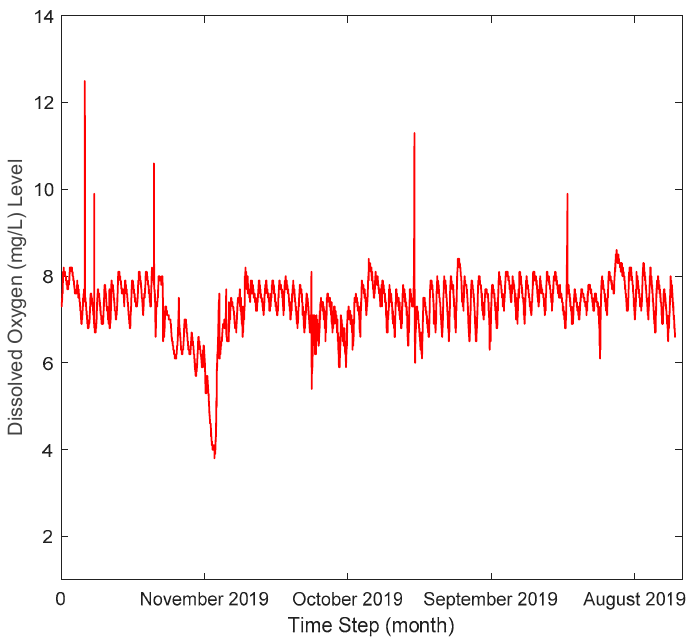
Figure 3. Four months’ distribution of the DO concentration raw data.